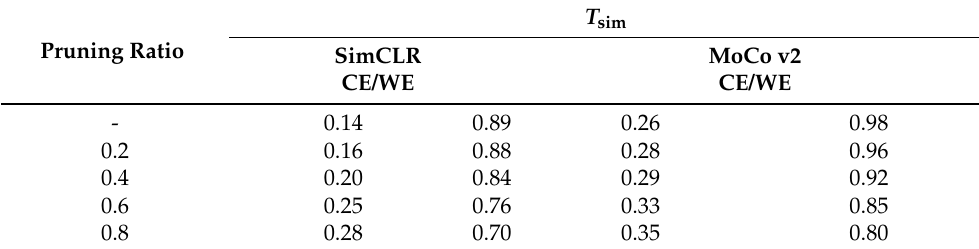
Table 5. Robustness against pruning (under white-box condition).